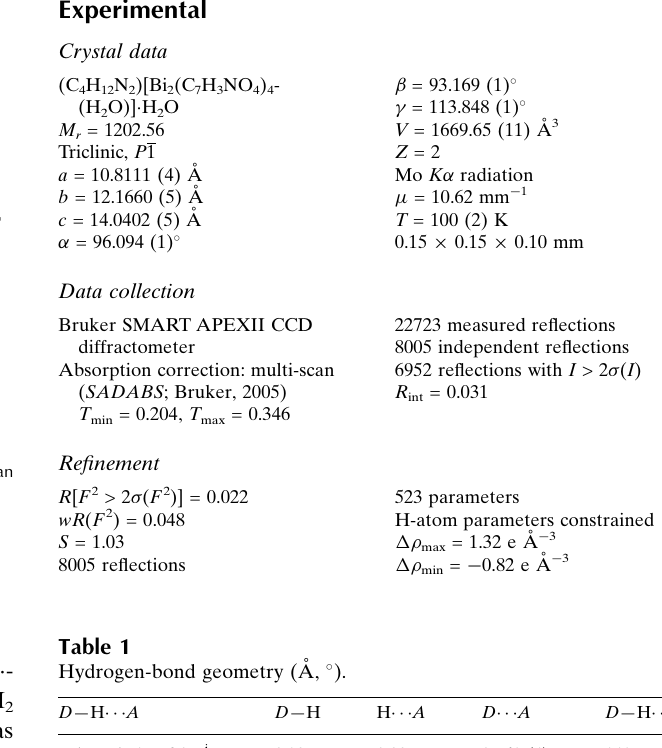
Key indicators: single-crystal X-ray study; T = 100 K; mean (cid:1) (C–C) = 0.005 A˚; R factor = 0.022; wR factor = 0.048; data-to-parameter ratio = 15.3. The title compound, {(C H N )[Bi (C H NO ) (H O)] (cid:1) - Hydrogen-bond geometry (A˚ , (cid:3) ). 4 12 2 2 7 3 4 4 2 O} or {(pipzH )[Bi (pydc) (H O)] (cid:1) H O} , where pydcH H n n 2 2 2 4 2 2 2 D —H (cid:1)(cid:1)(cid:1) is pyridine-2,6-dicarboxylic acid and pipz is piperazine, was (cid:1) 5H obtained by reaction of Bi(NO ) O with (pipzH )(pydc- 3 3 2 2 (cid:1) 3H O in a 1:2 molar ratio in aqueous solution. There are H) 2 2 two independent Bi III atoms in the structure, one of which is eight-coordinate with a distorted bicapped trigonal-prismatic geometry, and another which is nine-coordinate with a distorted tricapped trigonal-prismatic geometry. The carboxyl- ate groups of the (pydc) 2 (cid:2) ligands link dinuclear (C H NO ) (H O)] 2 (cid:2) units into one-dimensional coordin- [Bi 2 7 3 4 4 2 ation polymers. The pipzH 22+ cations (site symmetry 1) and